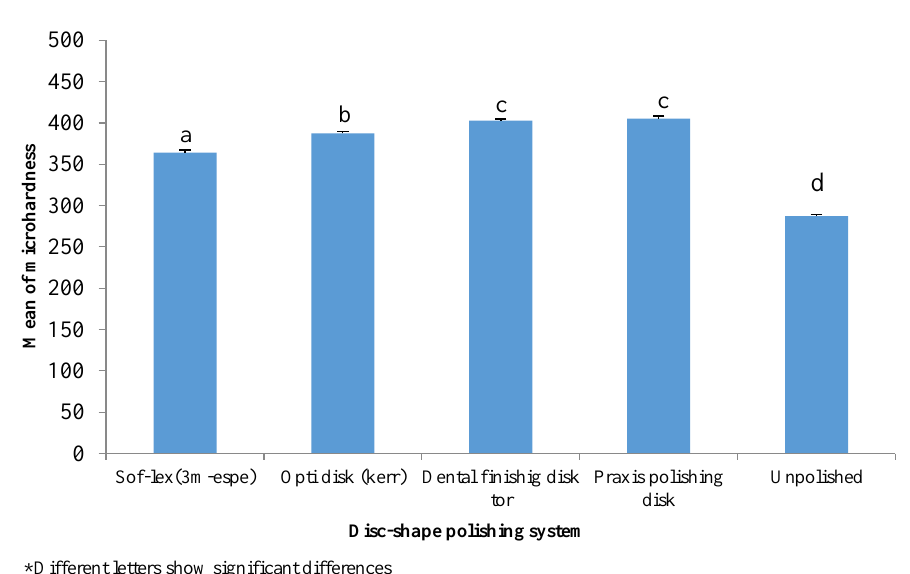
Fig. 2. Bar graph of the average micro-hardness of a nanohybrid composite according to disc-shaped polishing